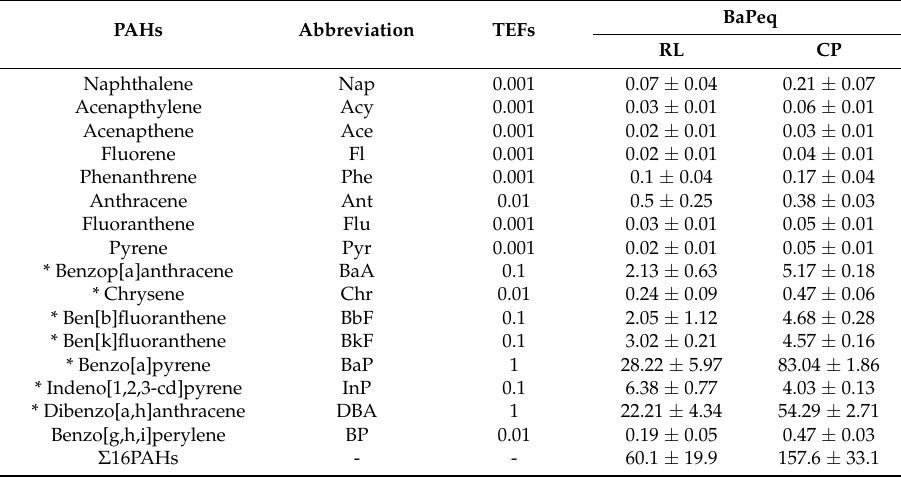
Table 3. Toxic equivalent concentration (BaPeq) ( µ g/kg) of PAHs in soils from the study areas.